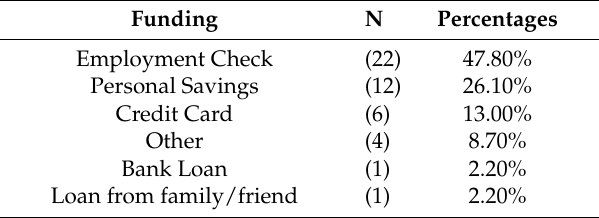
Table 14. Funding for Home Improvements by Houston Habitat Homeowners